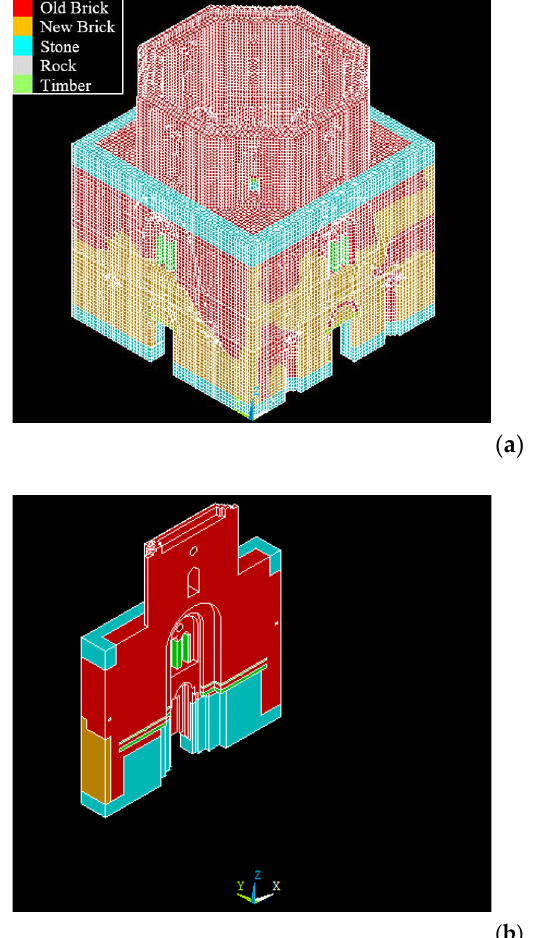
Figure 13. ( a ) Three-dimensional view of the ANSYS numerical model; ( b ) one of the walls viewed from inside the structure.